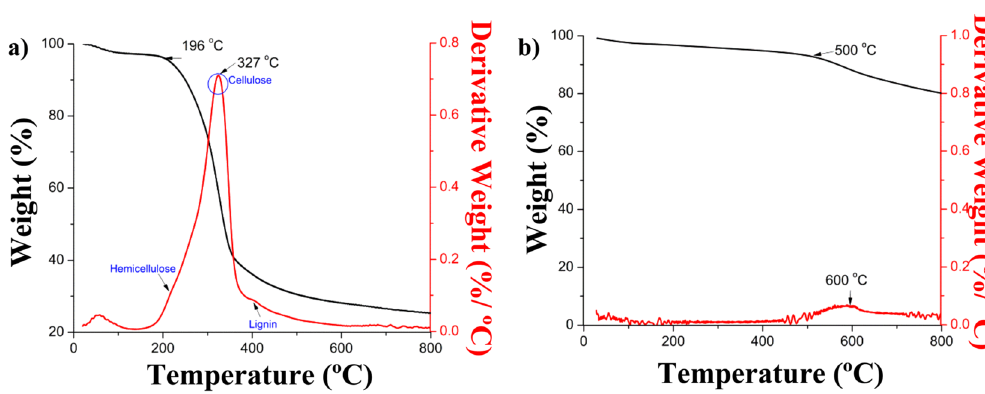
Figure 4. Thermogravimetric analysis of ( a ) peanut hulls and ( b ) 500 °C peanut hull